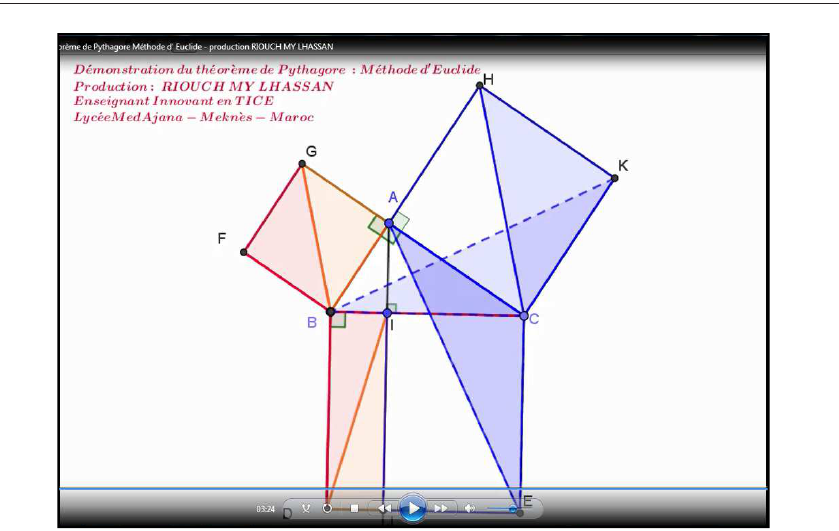
Fig.7. Film éducatif (Démonstration du théorème de Pythagore par la méthode d’Euclide). 4.5 Exemple 5 : Projet interdisciplinaire Arithmétique- situation